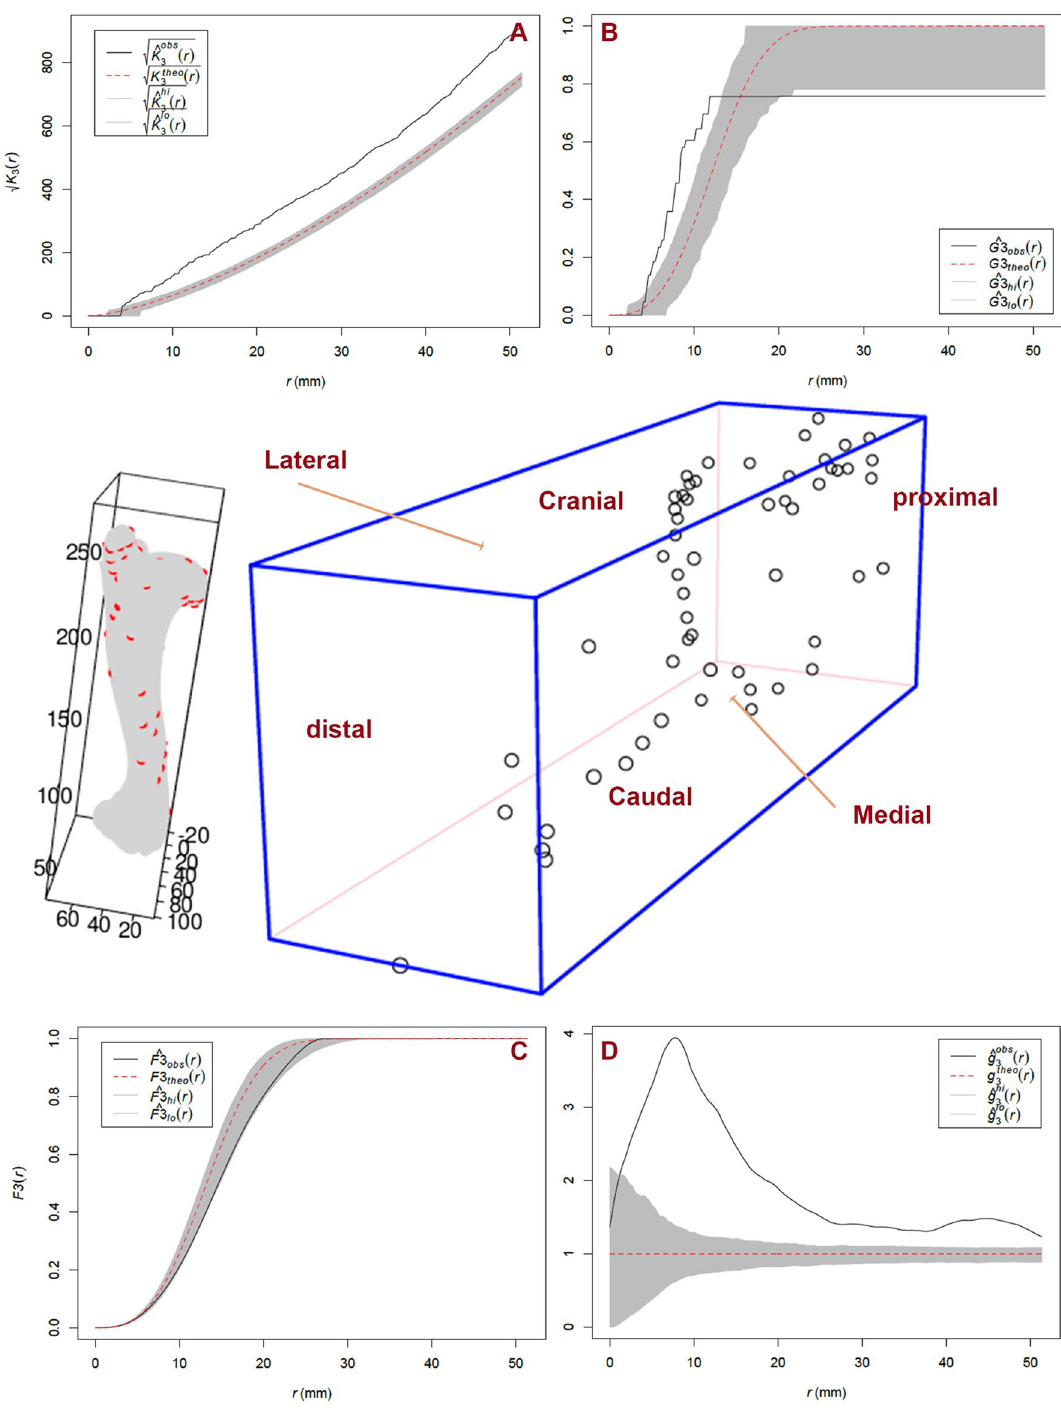
Figure 3. Three-dimensional plot of the distribution of tooth marks on the left humerus. ( A ) K-function plot. ( B ) G near-neighbour function plot. ( C ) F empty space function. ( C ) Pair-correlation function. The F function suggests a pattern non-differentiable from CSR. The other three functions suggest a mild clustering trend in short distances. Key to ( A,B,D ) Dotted red line shows the Poisson Complete Spatial Random (CSR) process and the gray band shows its confidence envelope. Black line shows the point process of the target sample (here, tooth marks on humerus). When above the CSR Poisson process, it indicates a clustering trend. When below, it indicates a regular scattering trend. The interpretation is reverse for ( C ) (F empty space function). Same interpretation applies to equivalent figures in the Supplementary